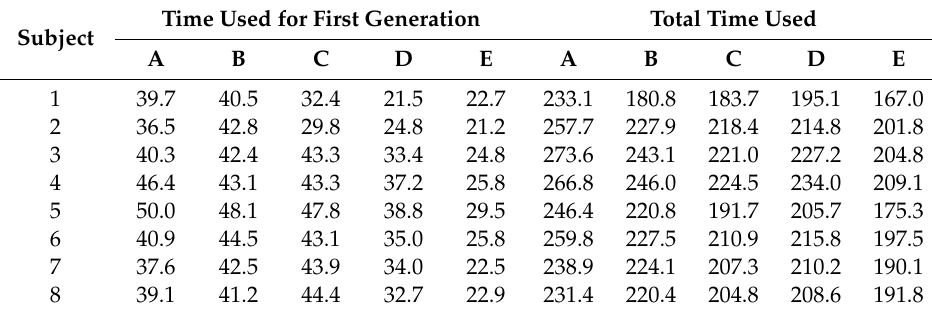
Table 3. Time used for first generation and total time used by five